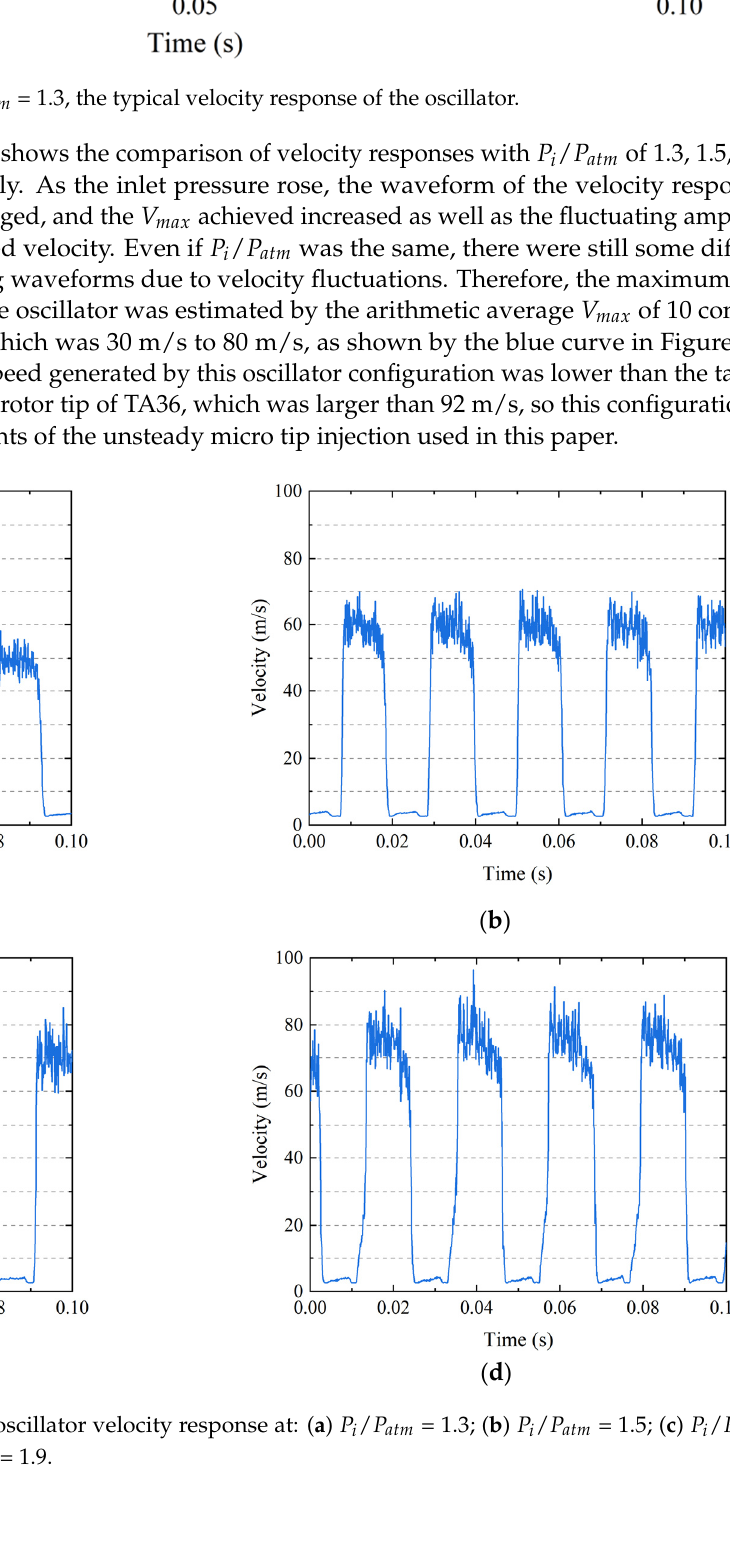
Figure 11. The oscillator’s average 𝑉 (cid:3040)(cid:3028)(cid:3051) and mass flow rate response. 3.1.3. Mass Flow Response The mass flow response of this oscillator is shown by the red curve in Figure 11. Re- stricted by the throat area, the flow rate increases monotonically with the increase of the inlet pressure. When the range of 𝑃 (cid:3036) /𝑃 (cid:3028)(cid:3047)(cid:3040) was 1.1 to 2.0, a single oscillator mass flow rate was from 0.115 g/s to 0.388 g/s. The dimensionless parameter 𝑀 (cid:3041) is the per millage of the oscillator flow rate to the design flow rate of the compressor TA36. In Figure 11, the 𝑀 (cid:3041) of a single oscillator ranges from 0.017 to 0.059, which is far less than the design flow rate of the compressor and meets the micro-injection requirement of the experiments. In summary, this new oscillator configuration can realize the three frequencies re- lated to the unstable phenomena of TA 36 by adjusting the feedback channel length. It can also achieve response frequency/period-pressure decoupling as an empirical formula be- tween frequency/period and the feedback channel length was established, which is help- ful to predict and select the corresponding target frequency. The 𝑃 (cid:3036) /𝑃 (cid:3028)(cid:3047)(cid:3040) range was be- tween 1.1 and 2.0, and the maximum jet velocity range was 30 m/s to 80 m/s, which was smaller than the flow velocity at the rotor tip region. The mass flow range of the single oscillator was only 0.017~0.059‰ of the designed compressor flow rate, which ensures that the excitations were micro-injections, and the jet energy basically does not cause effi- ciency penalty.